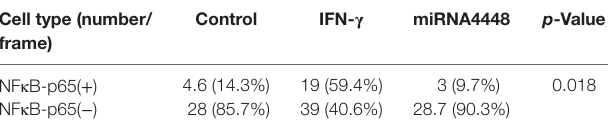
TaBle 3 | NF κ B-p65 positive and negative cell numbers.